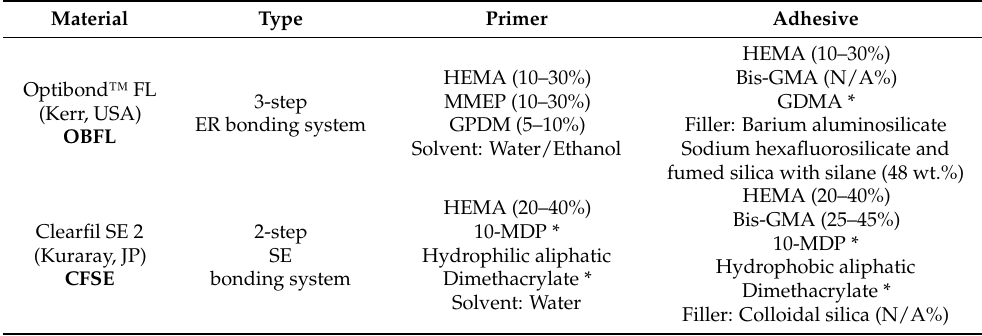
Table 1. Bonding system source, type and composition according to the manufacturers and safety.